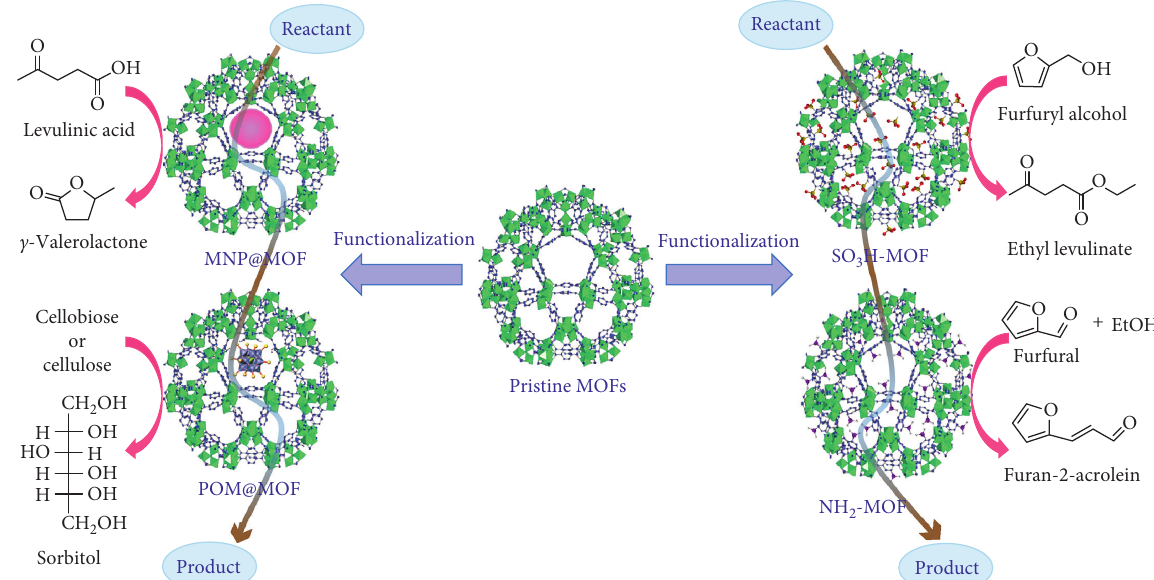
Figure 1: Application of MOFs for partial biomass